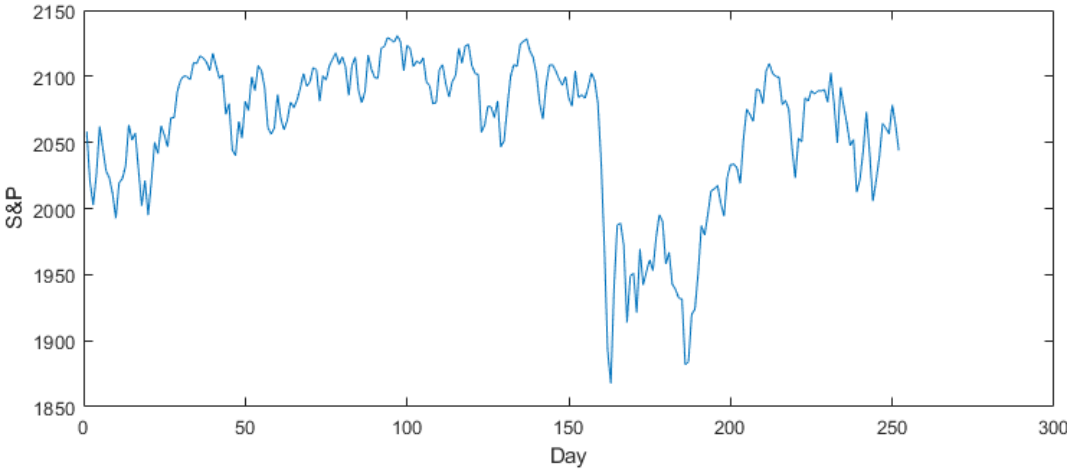
Figure 4. The triangular fuzzy numbers of the S&P dataset. A 12 × 1 matrix of the current year Y and 12 × 1 matrices of 12 sliding windows ( SW ) were formed from the data and tabulated, as shown in Table 1.